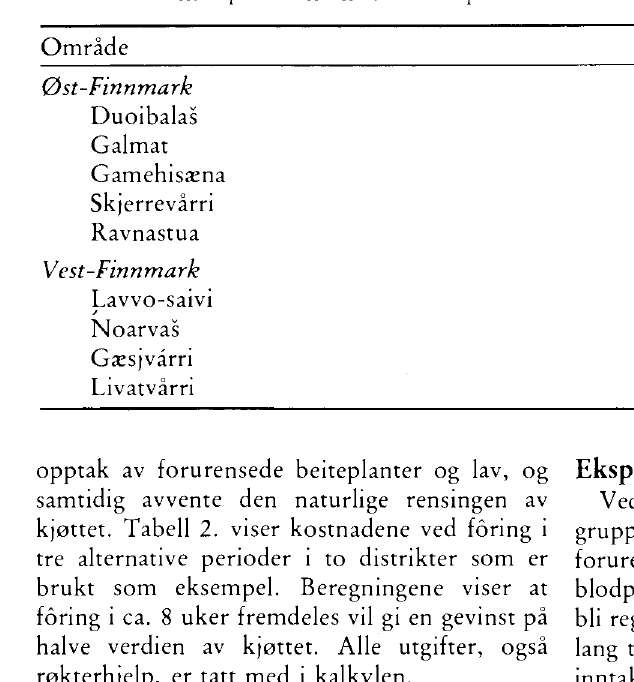
Tabeli 1. Konsentrasjon av cesium (134, 137) i lav fra Finnmark. Prøvene er samlet inn 16. scpternber 1986. n = antall prøver innen et område på ca. 200 m'.